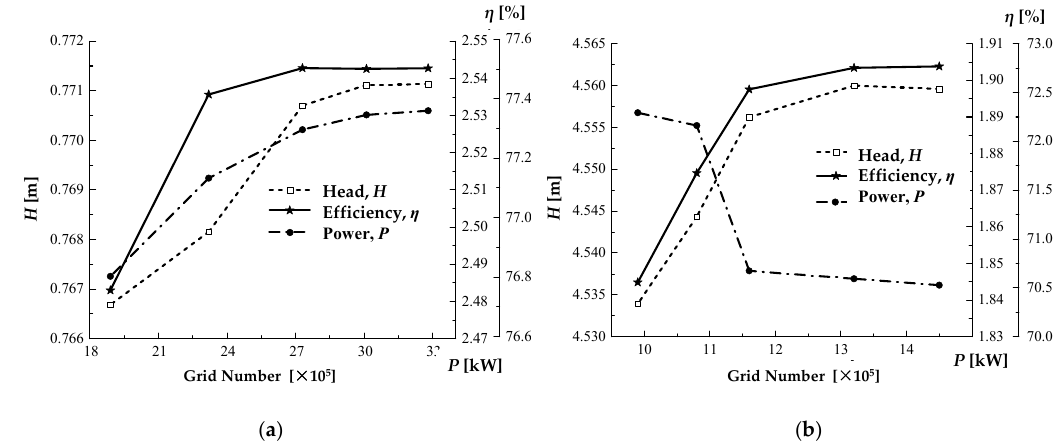
Figure 4. Grid independence curves: ( a ) turbine condition and ( b ) pump condition.